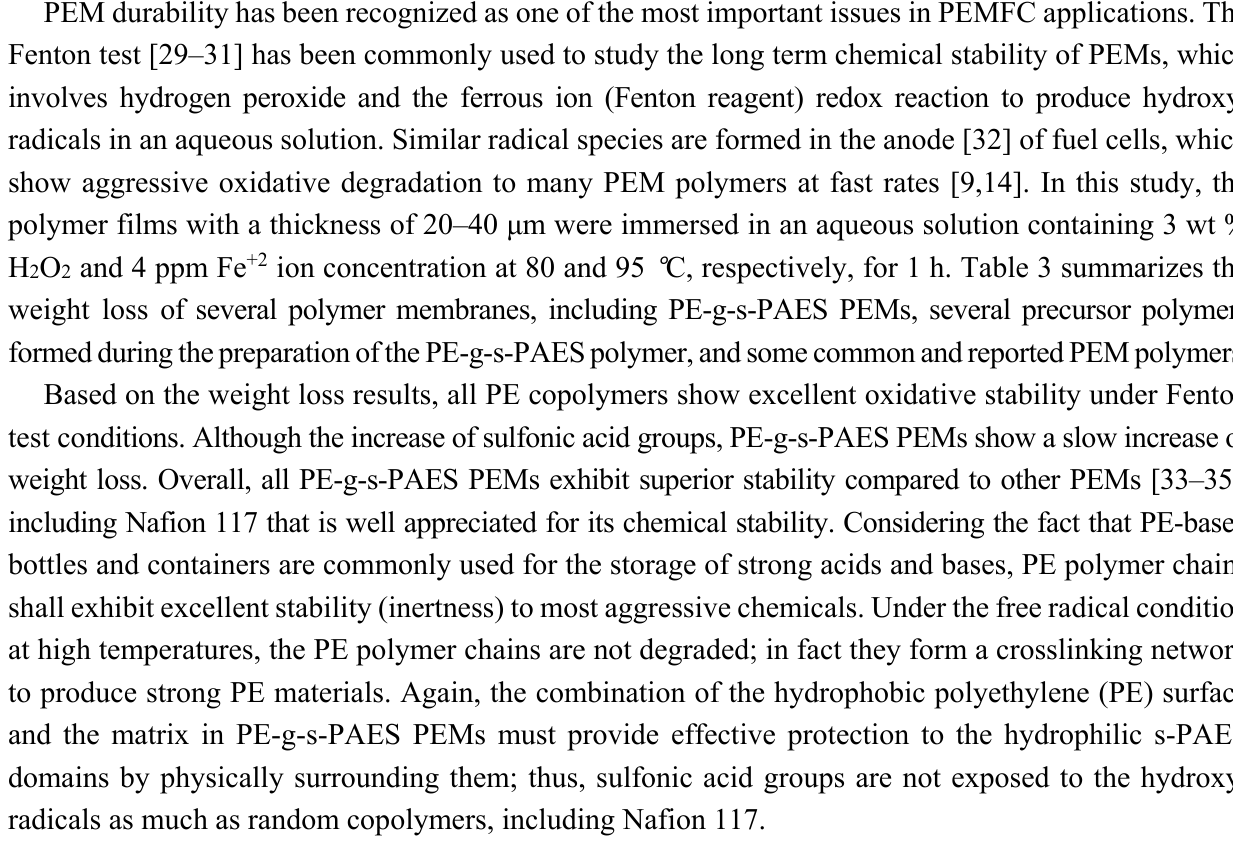
Table 3. Summary of chemical stability of PE-g-s-PAES and reference